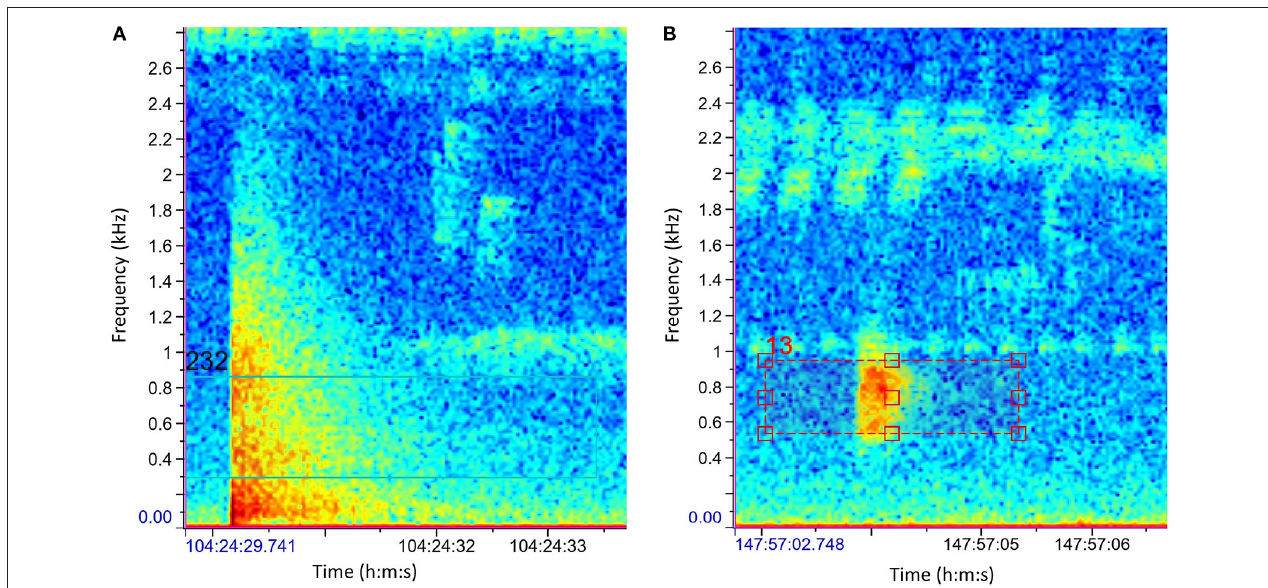
FIGURE 2 | Output spectrograms of the Automatic Detection Algorithm and the score assigned by the algorithm to an actual gunshot (A) and a false positive, a bird call (B) . Color indicates sound intensity, with blue being lowest and red highest. Gunshots are characterized by a broad, sudden increase in intensity followed by a gradual